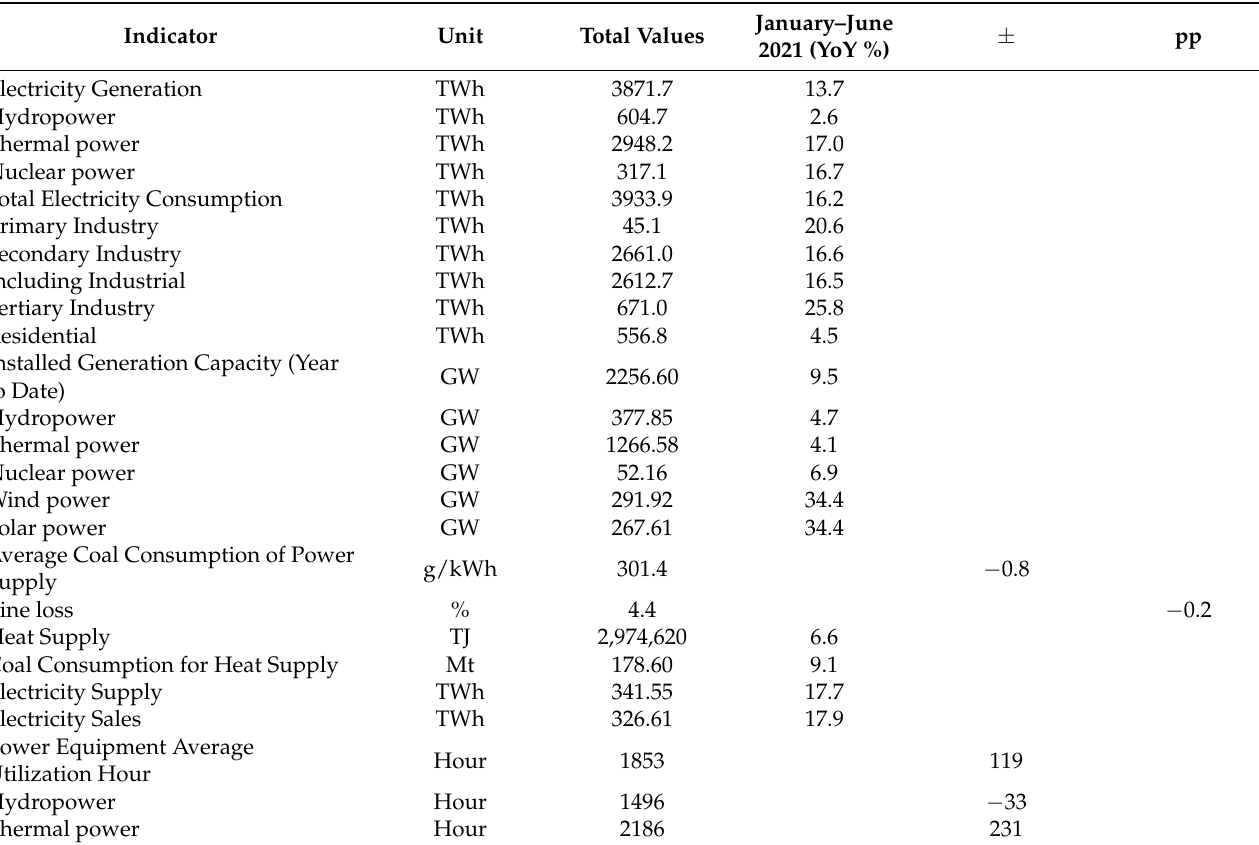
Table 6. Statistic on China’s power sector for the first two-quarters of January to June 2021 [75]. Source: CEC (2021) Statistics of China Power Industry. All rights